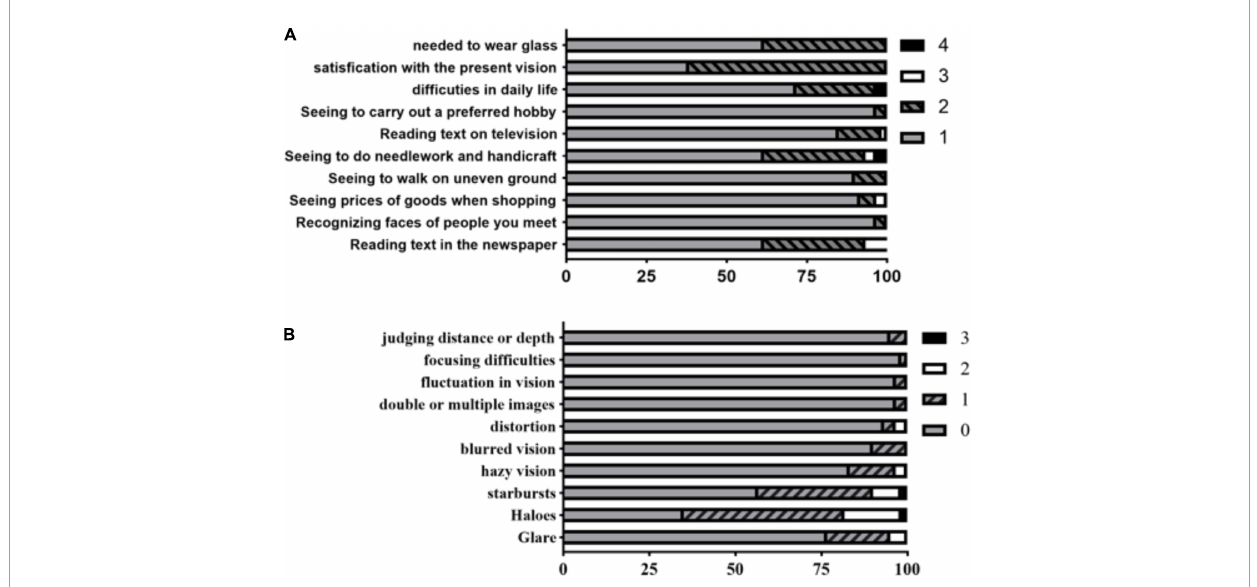
FIGURE3 The Catquest-9SF questionnaire perceived difficulty scores in performing daily-life activities. There are four (summary scoring value) response options for the perceived difficulty levels as follows: 4 = very great difficulty; 3 = great difficulty; 2 = some difficulty; 1 = no difficulty (A) . The Quality of Vision (QoV) questionnaire were asked to rate 10 dysphotopsia items with 4 response levels (0, 1, 2, 3; higher score means worse photic phenomena) (B) .